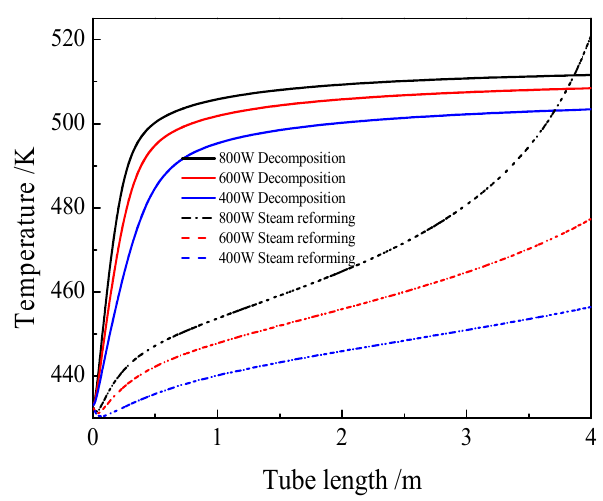
Figure 6. Catalyst bed temperature Variation with solar flux for steam reforming and methanol decomposition. Fig. 6.Variation of temperature of the catalyst bed with solar flux for steam reforming and 257